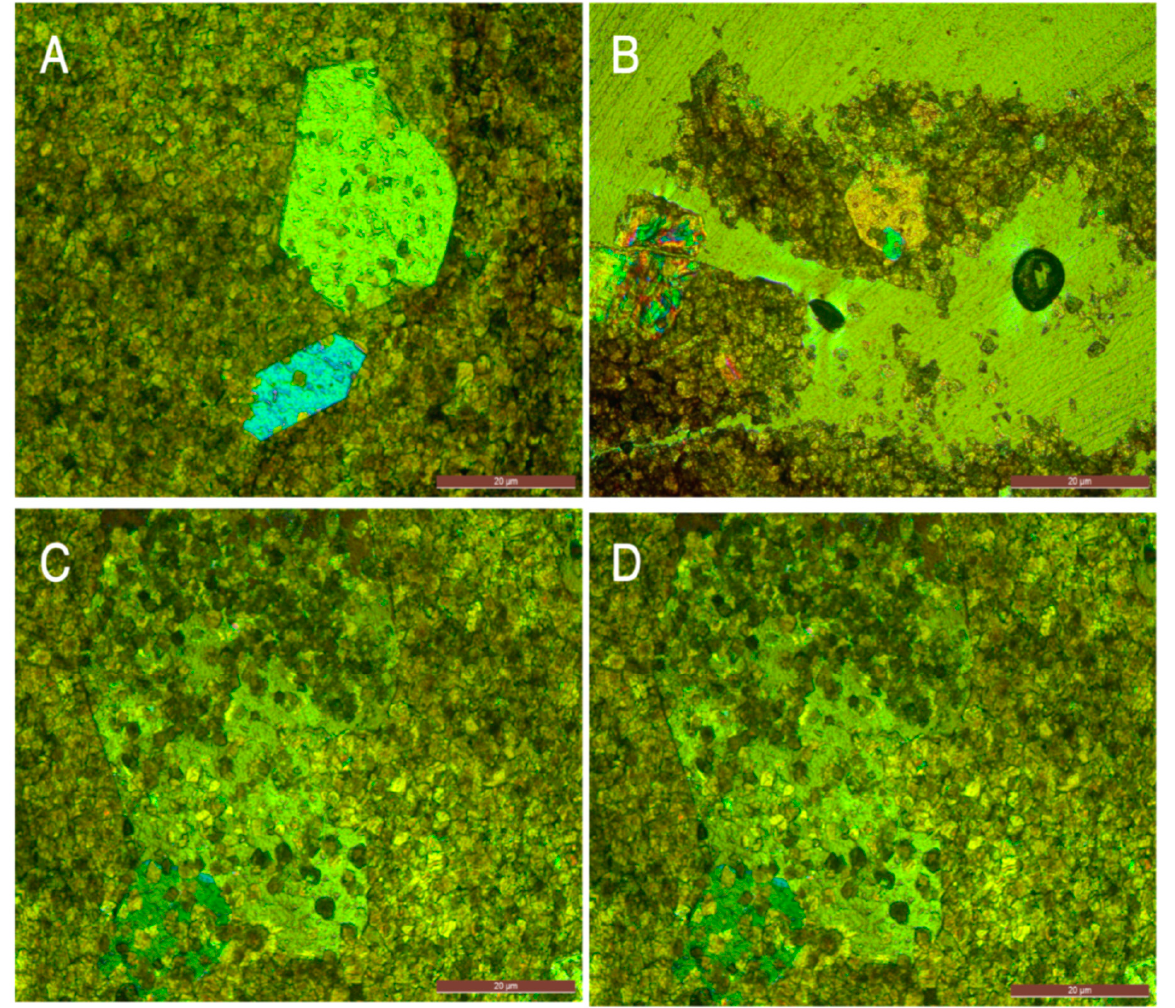
Figure 6. ( A – D ) Photomicrographs illustrate the weathered clasts of quartz from outside of the Barsarin basin, close up the eroded outline of polygonal grains ( B ) and other detrital grains in ( C,D ) that embedded in host carbonate rocks.